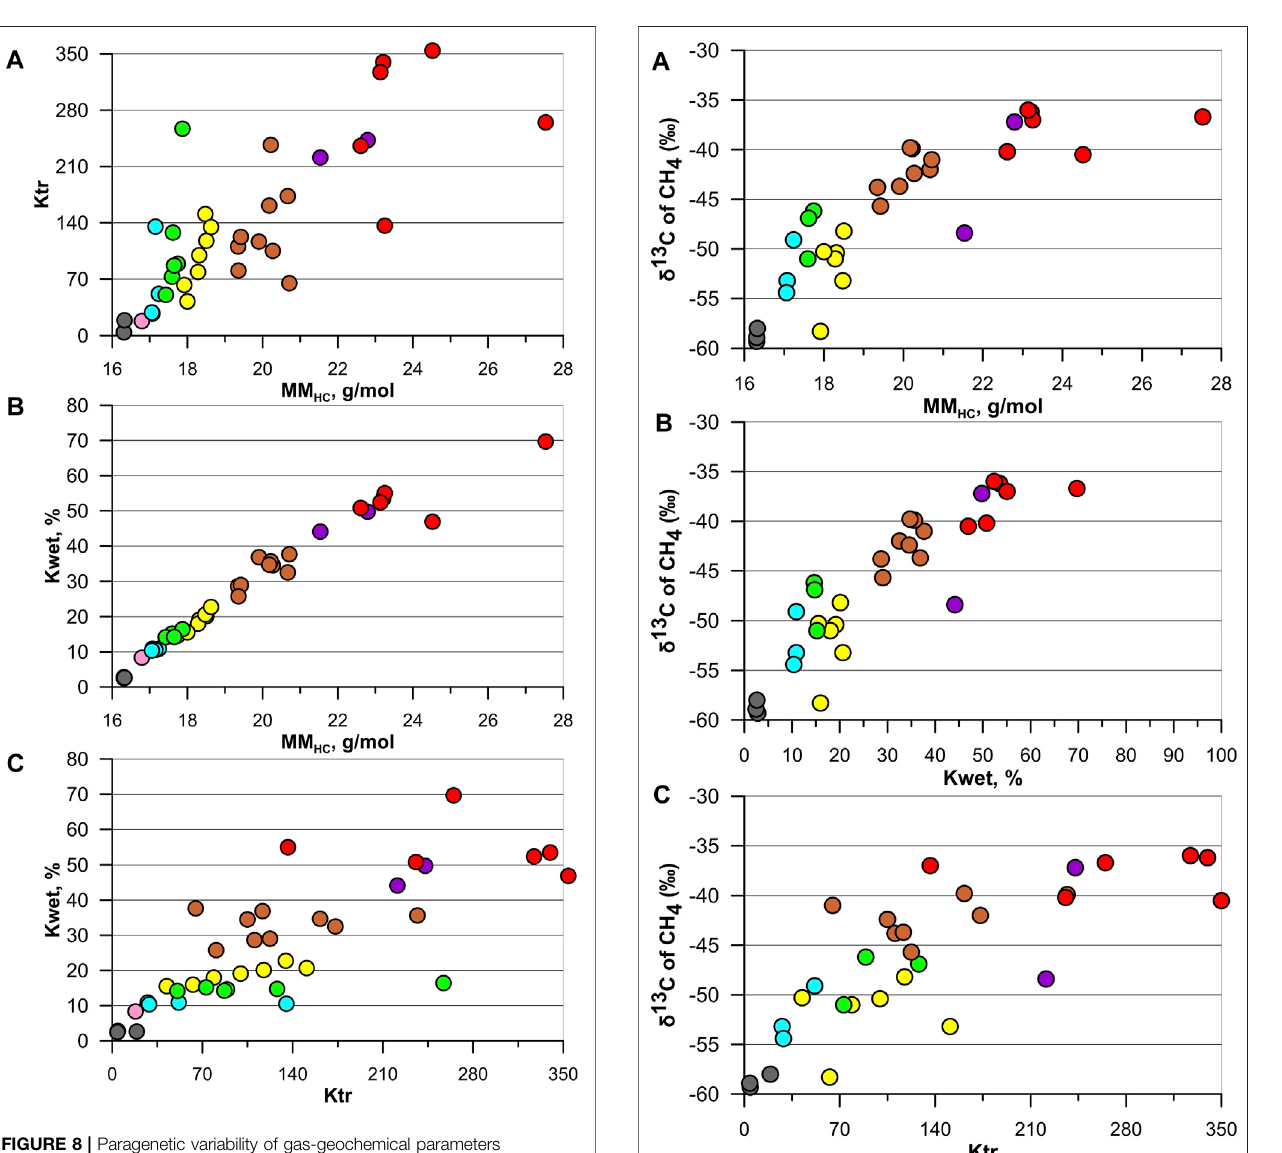
FIGURE 8 | Paragenetic variability of gas-geochemical parameters MM HC -Ktr (A) , MM HC -Kwet (B) , and Kwet-Ktr (C) . Genetic groups are the same such as in Figure 5 . FIGURE 9 | Paragenetic variability of gas-geochemical and carbon